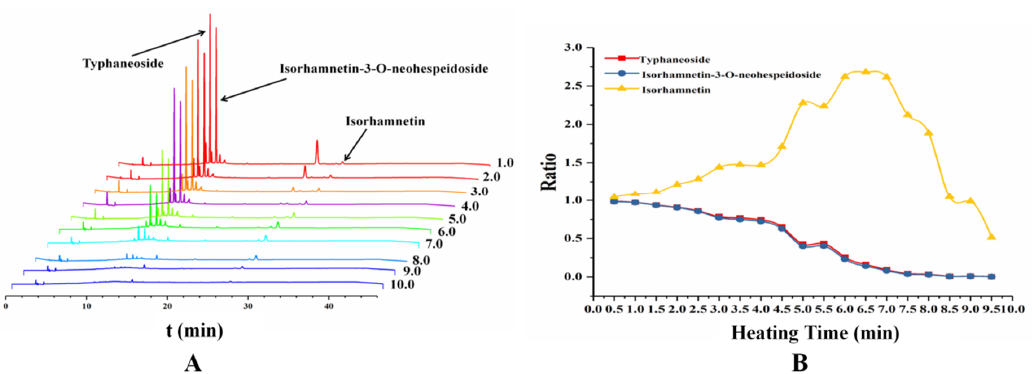
Figure 6. The content changes of the two main flavonoid glycosides and its aglycone in different samples heated from 1 to 10 min. ( A ) the HPLC chromatography of different samples from heating for 1 min to 10 min and ( B ) the ratio of compounds content in pollen grains compared with PT.